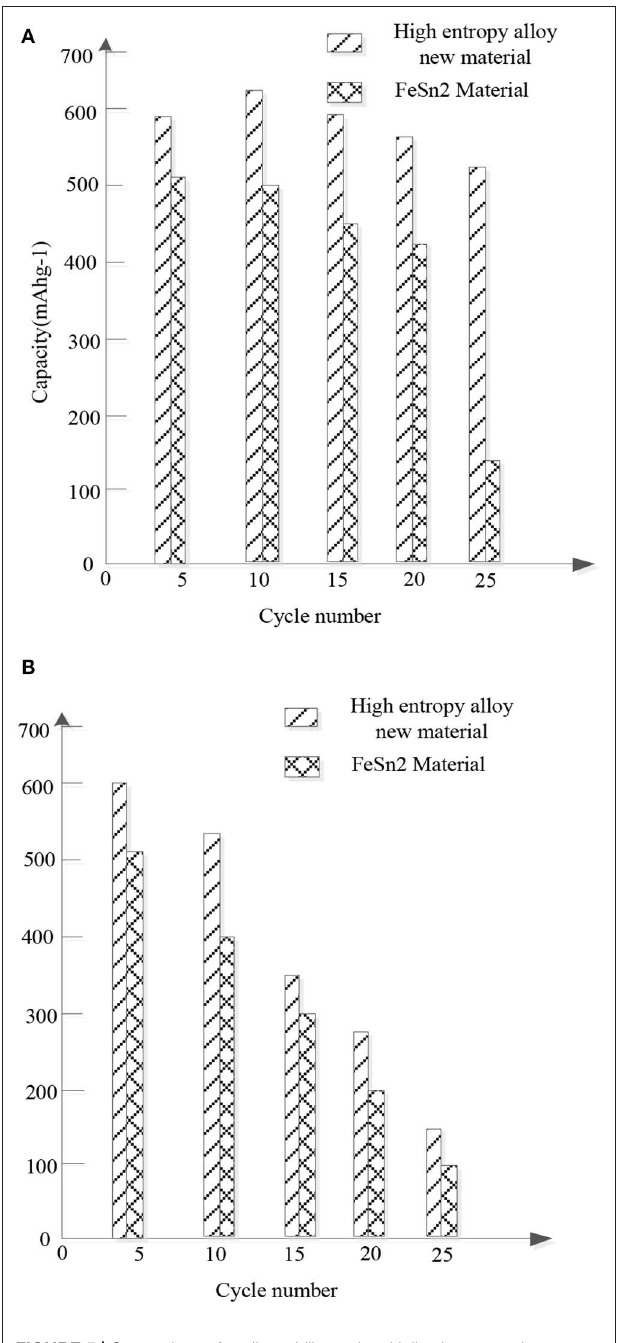
FIGURE 5 | Comparison of cyclic stability and multiplicative properties between the new high entropy alloy material and FeSn 2 material samples. (A) Cyclic stability. (B) Ratio of performance.